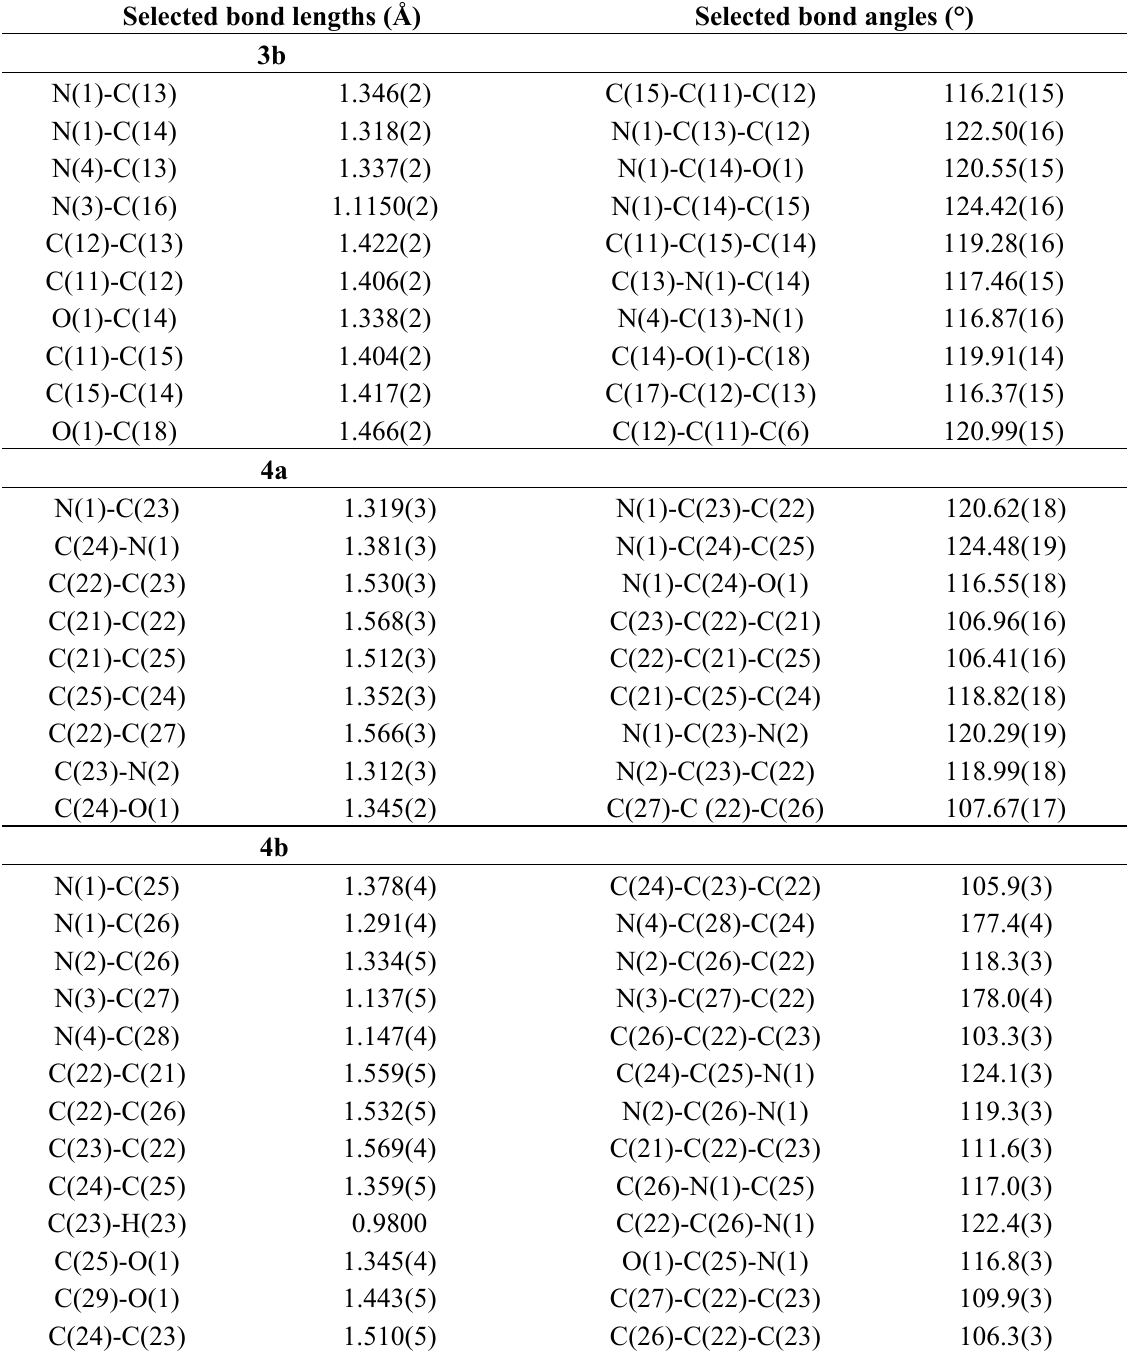
Table 1. Selected bond lengths and bond angles for compounds 3b , 4a and 4b